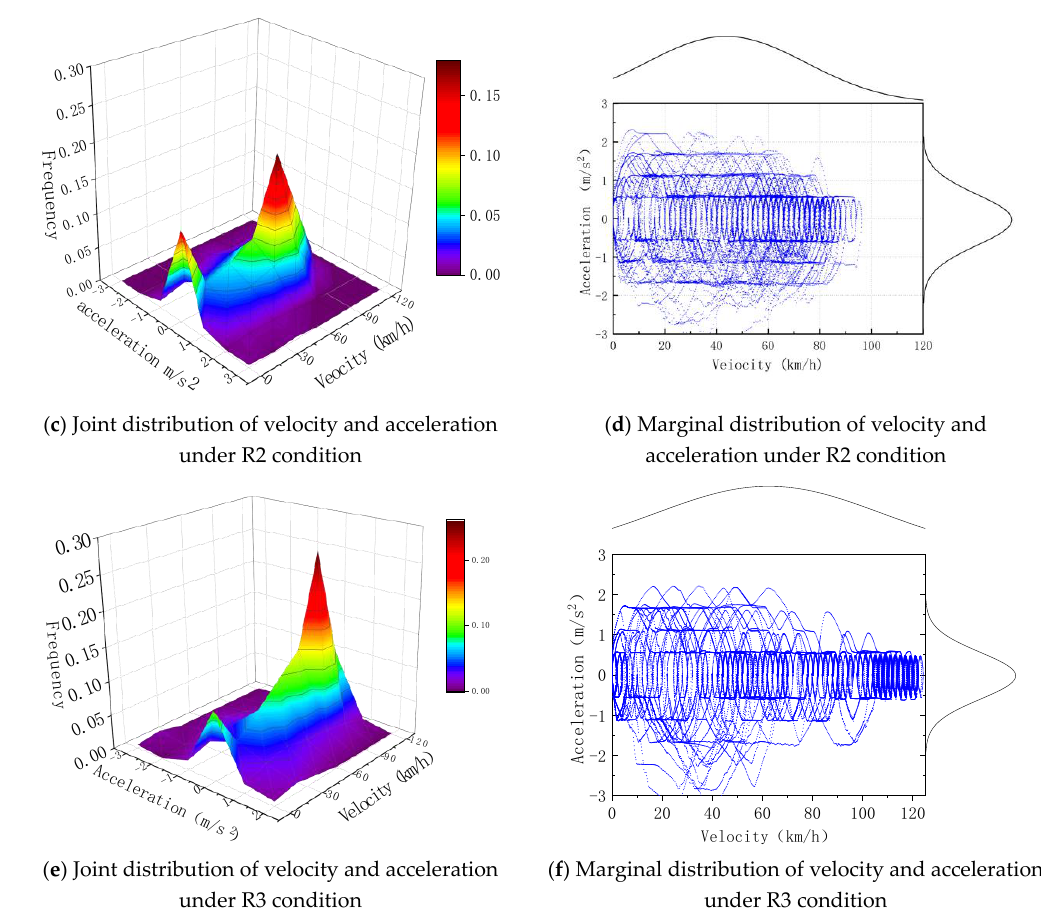
Figure 3. Probability distribution of velocity and acceleration in three road conditions.